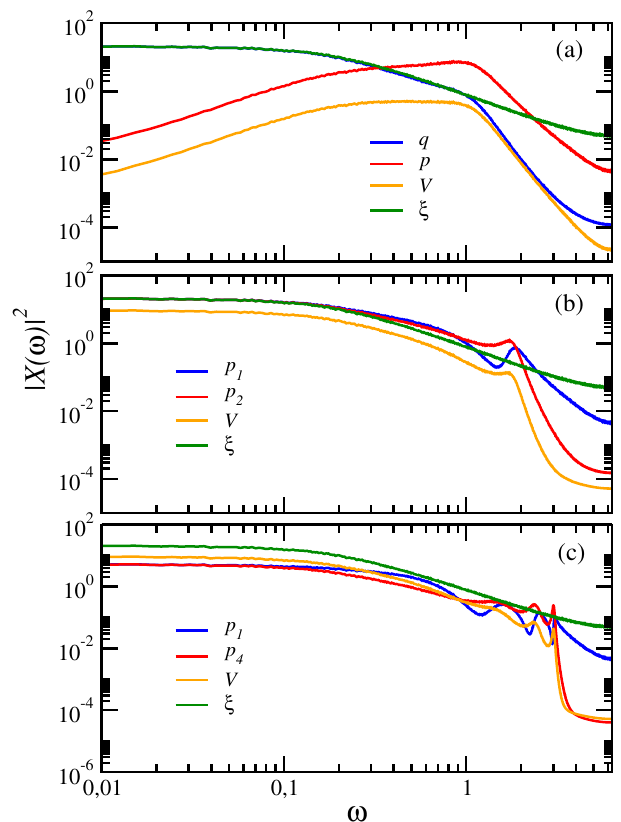
2 � for the single oscillator system variables (red), voltage (orange), and the OU noise (green). ( c ) N